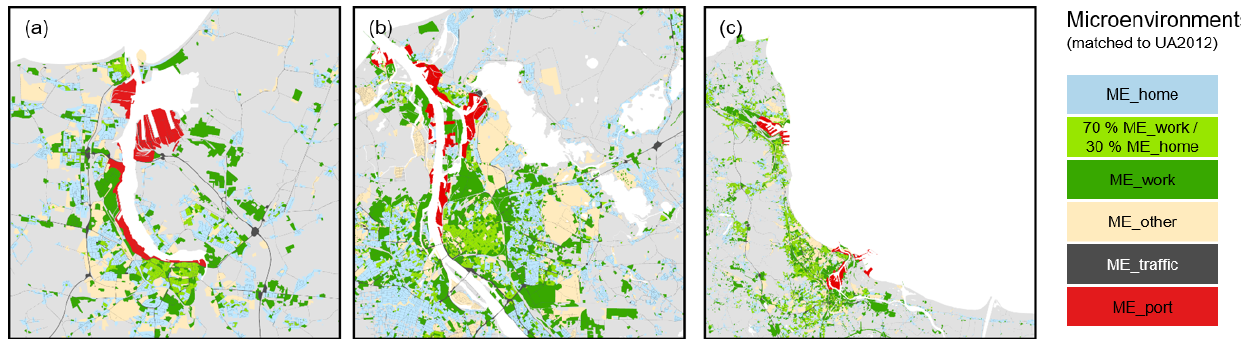
Figure 3. Urban Atlas land use classifications, aggregated by colours according to microenvironment mapping presented in Table 2 for